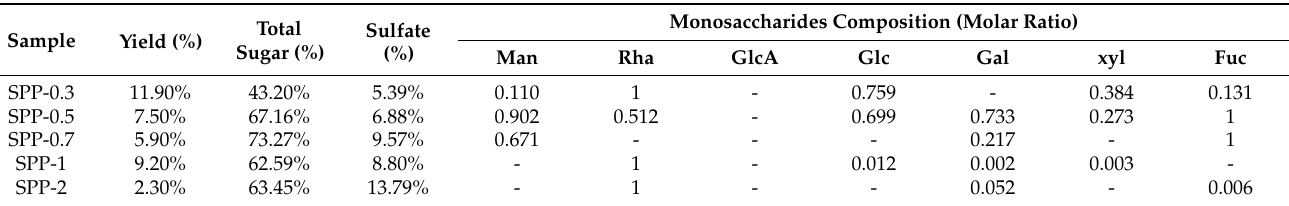
Table 1. Yield and chemical composition of the five polysaccharide fractions extracted from Sargassum pallidum .